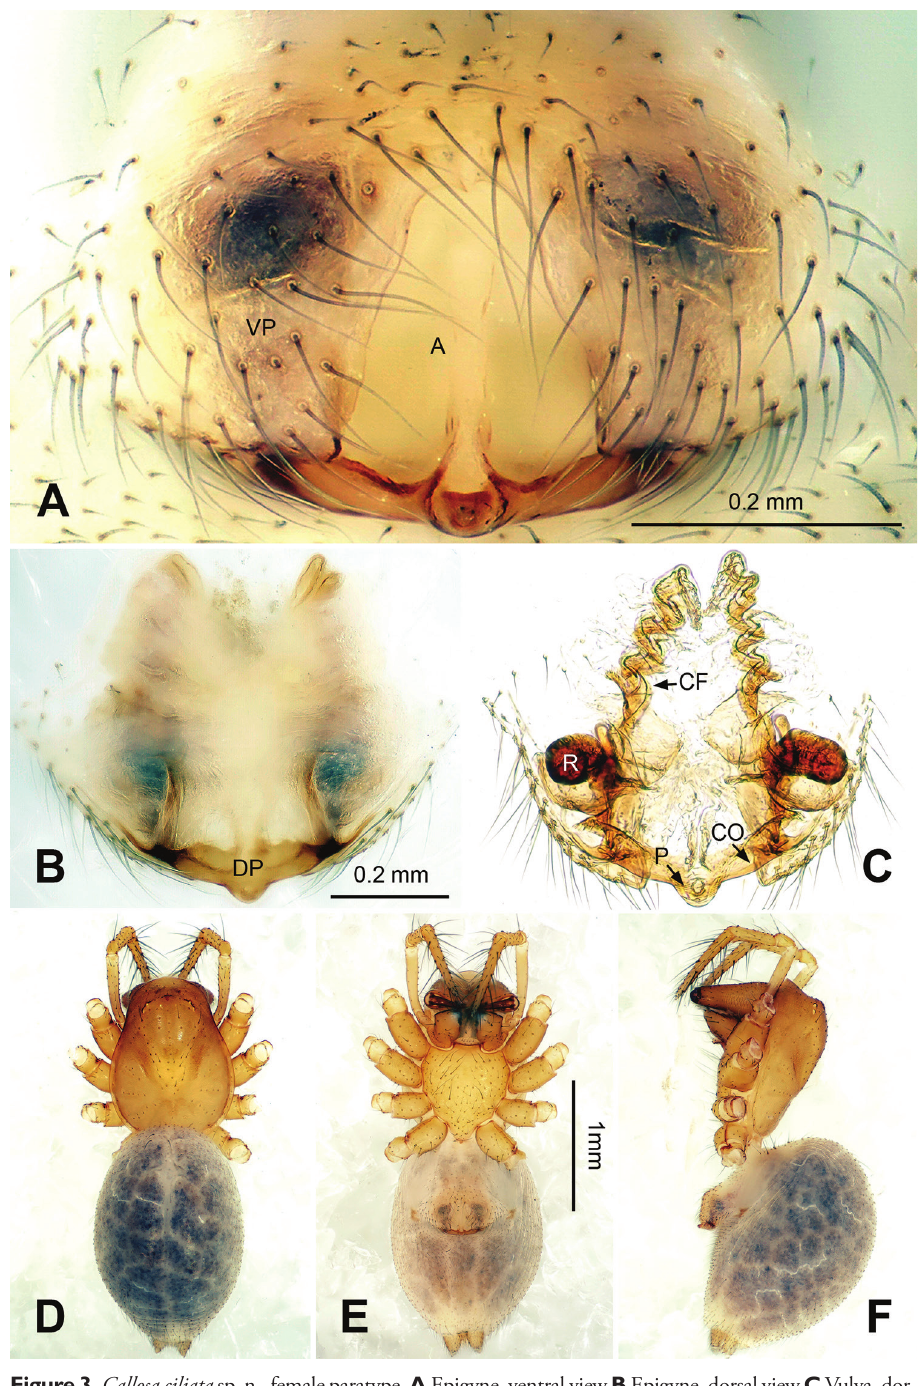
Figure 3. Callosa ciliata sp. n., female paratype. A Epigyne, ventral view B Epigyne, dorsal view C Vulva, dor- sal view D Habitus, dorsal view E Habitus, ventral view F Habitus lateral view. Scale bars: C as B ; D , F as E